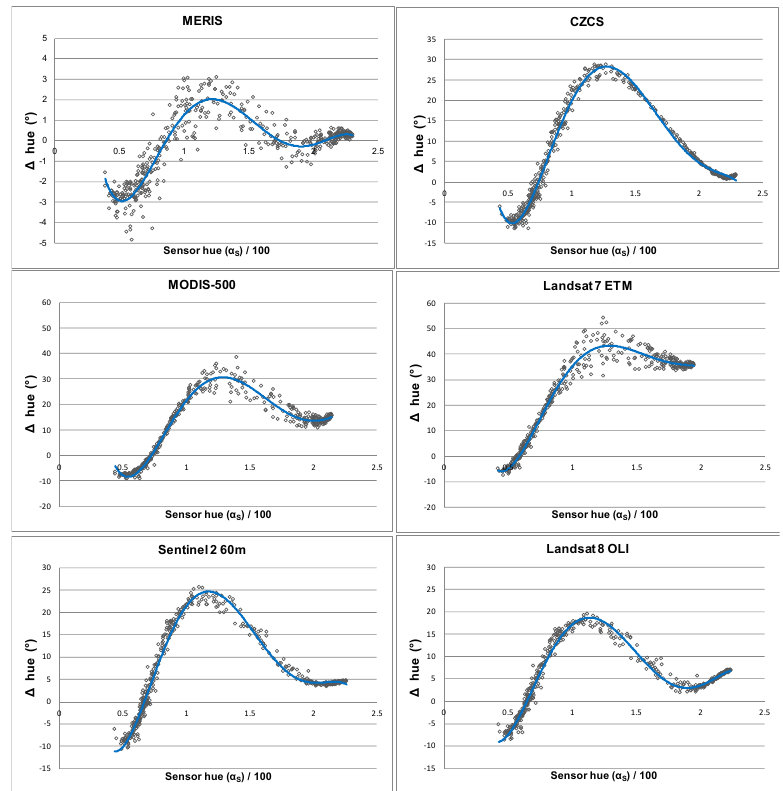
Figure 4. Deviation in degrees from the hyperspectral hue angle for six instruments. The horizontal axis gives the hue angle based on the reconstructed spectra (scaled by 100 for practical reasons). Note that, although the shape follows the same pattern for all of the instruments, the vertical scale is very different. The drawn line is the fifth order polynomial fit to the data. The best approximation of the true colour of water is reached by adding this Δ correction to the results of Equations (2) and (3). In Table 2, the polynomial coefficients are given for all of the instrument configurations.